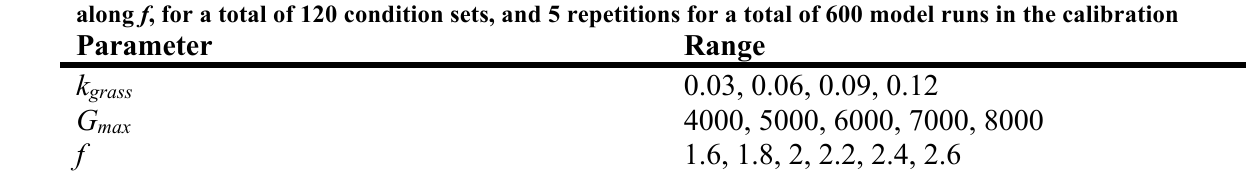
, 5 points along G , and 6 points grass max